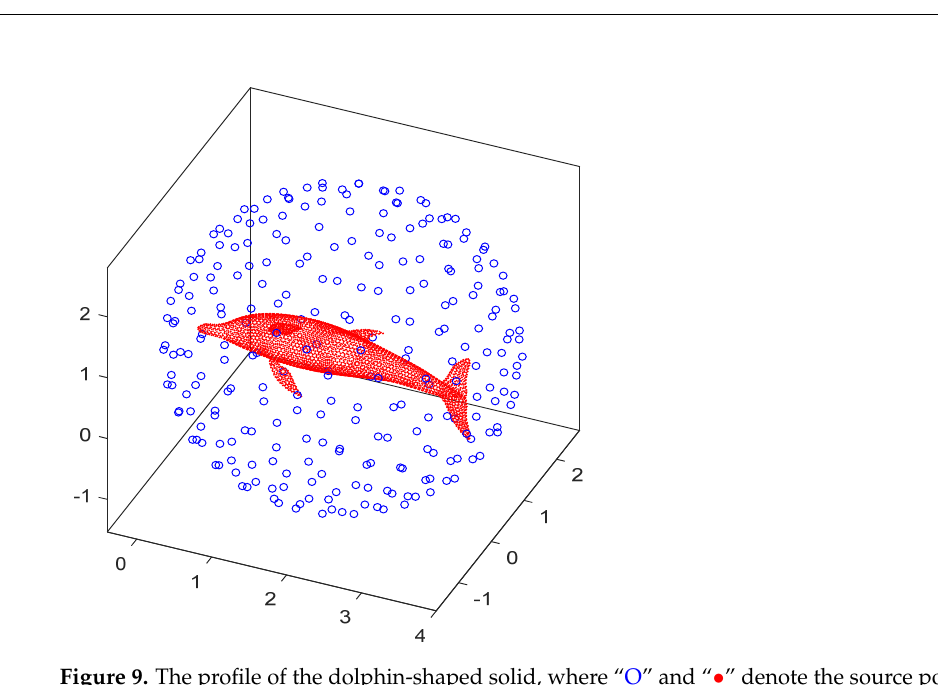
Figure 9. The profile of the dolphin-shaped solid, where “O” and “•” denote the source points (MFS) and boundary points, respectively. Table 3. Numerical results with respect to various degrees of Fourier polynomials. Degrees of Fourier